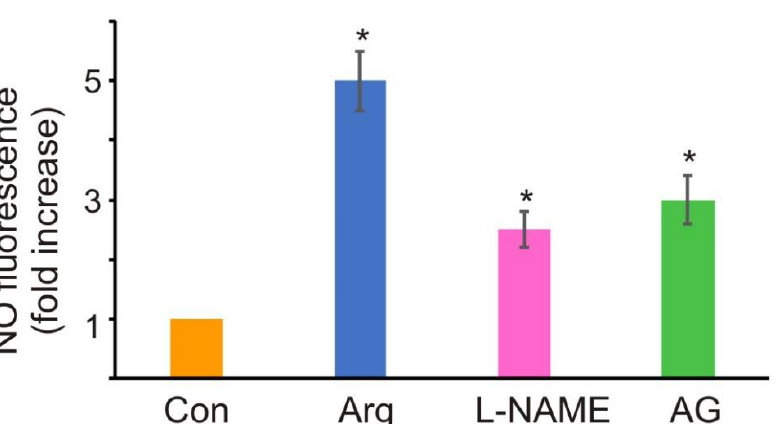
Figure 3. Effects of NOS inhibitors on NO synthesis. NO fluorescence was determined in P. parva cells treated with 1 mM Arg (pH 7.0) in the presence and absence (Con) of the NOS inhibitors, L-NAME (1 mM) or AG (2 mM), for 0.5 h. Data are expressed as the fold increase with respect to the control. Data are presented as the mean ± SE of three independent experiments. * denotes significant differences between the control (Con) and test variants according to the Student’s t test ( p value < 0.01).